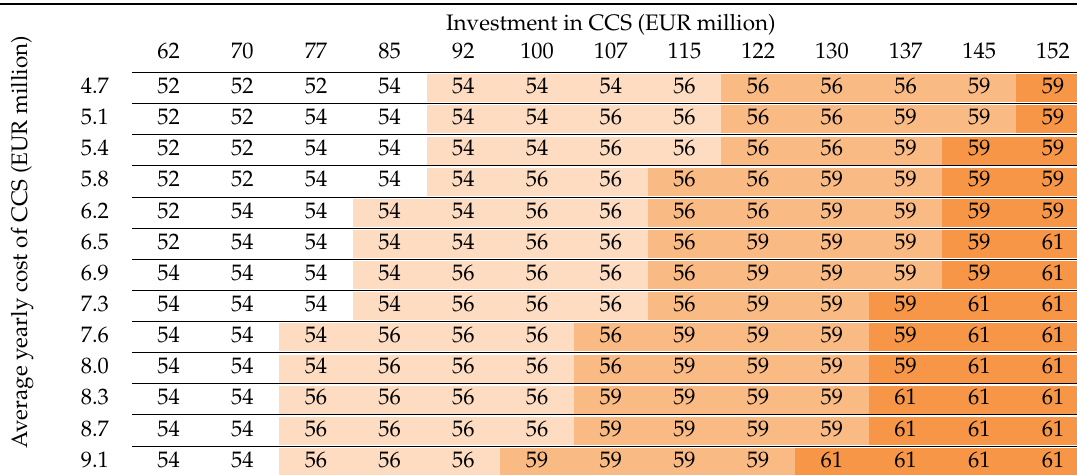
Table 16. Limit price of CO 2 allowances for CCS profitability (EUR)—lignite